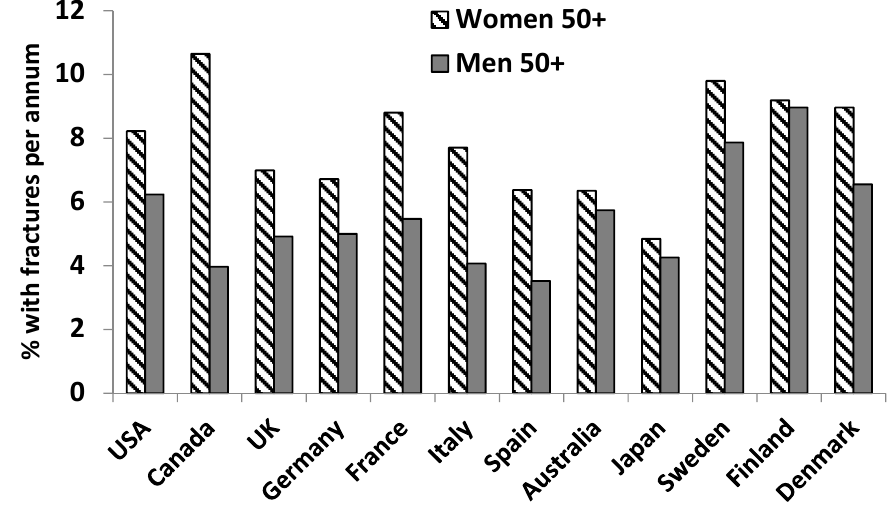
Figure 3. Non-traumatic fracture incidence (per 100 people) of hip, vertebral, and other bones for women versus men aged 50+ in select countries in 2010. Graph compiled from data published in Wade et al . [6].